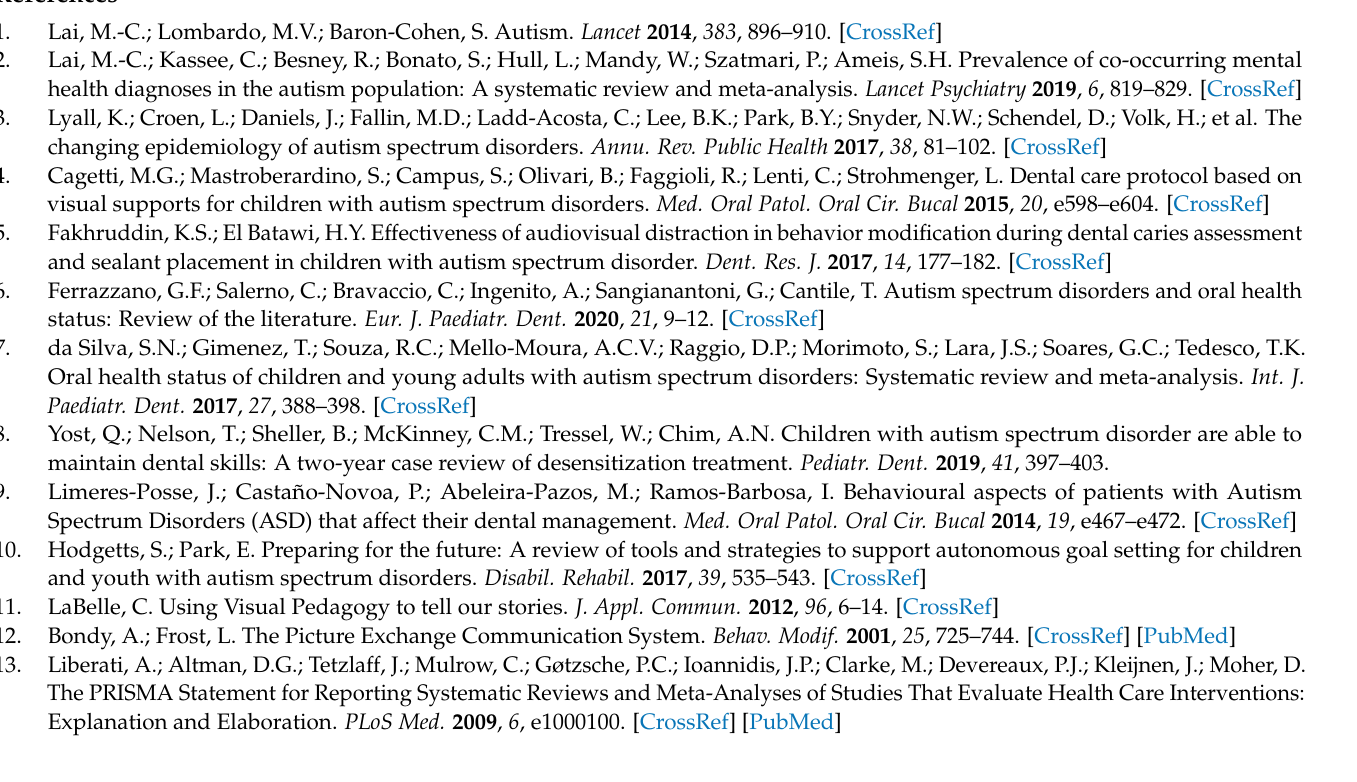
Table S3: List of excluded papers after full text